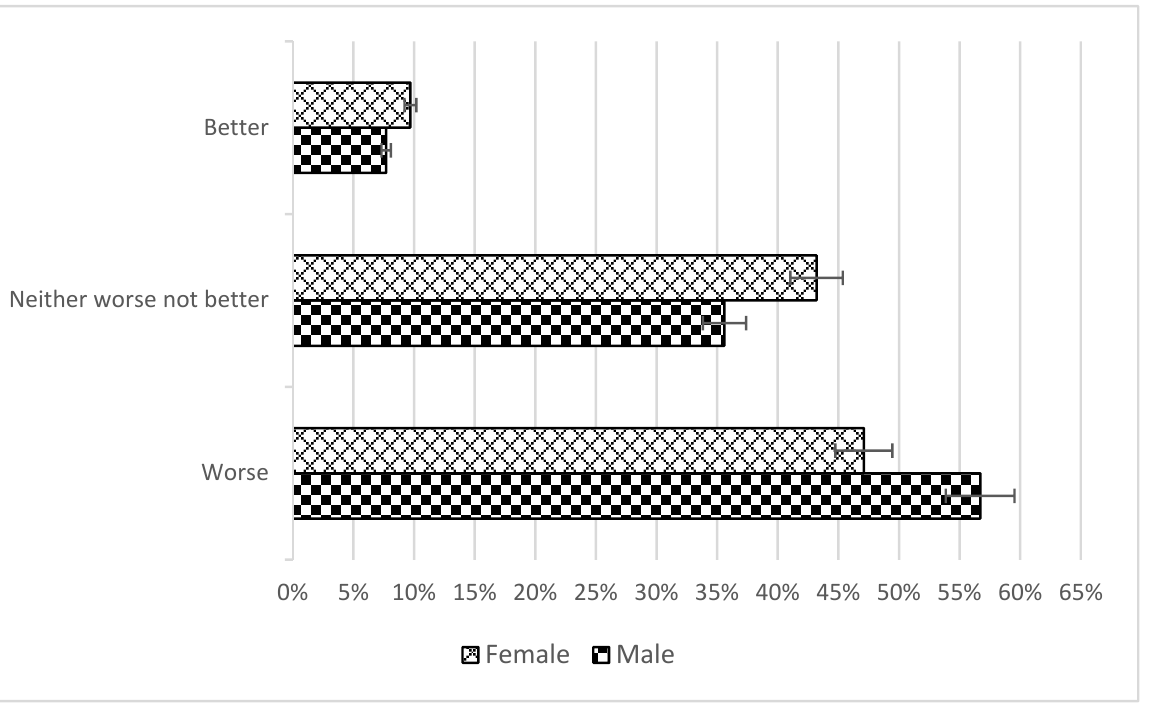
Figure 1. Distribution by gender of responses to the question “Overall, how would you rate your life under curfew compared to before the epidemic?”.